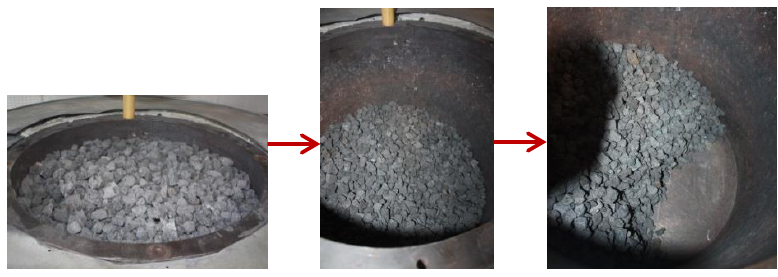
Figure 12. Uniaxial Compression Tests (UTC) results of slag as received.